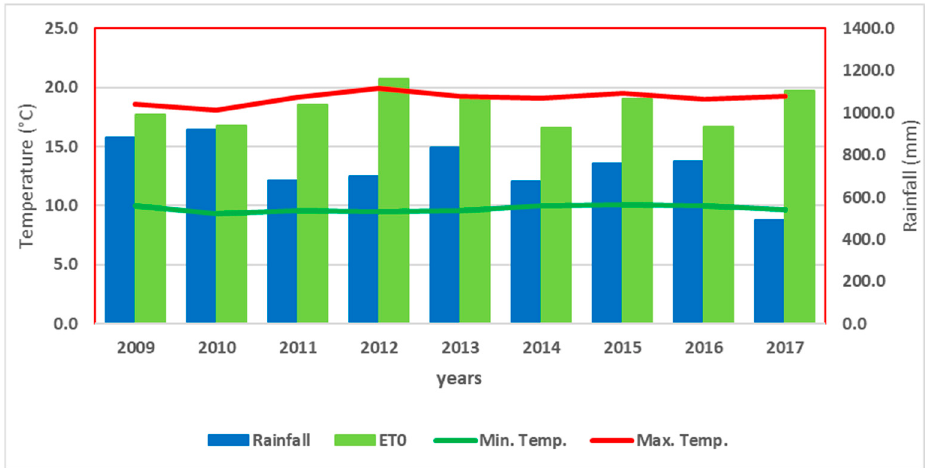
Figure 3. Average values for the maximum and minimum annual temperature, rainfall (mm/year), and potential evapotranspiration (ET0—mm/year) relative to the last ten years for province of Potenza (Basilicata Region) (source: Ministry of Agricultural, Food and Forestry Policies-Italy).